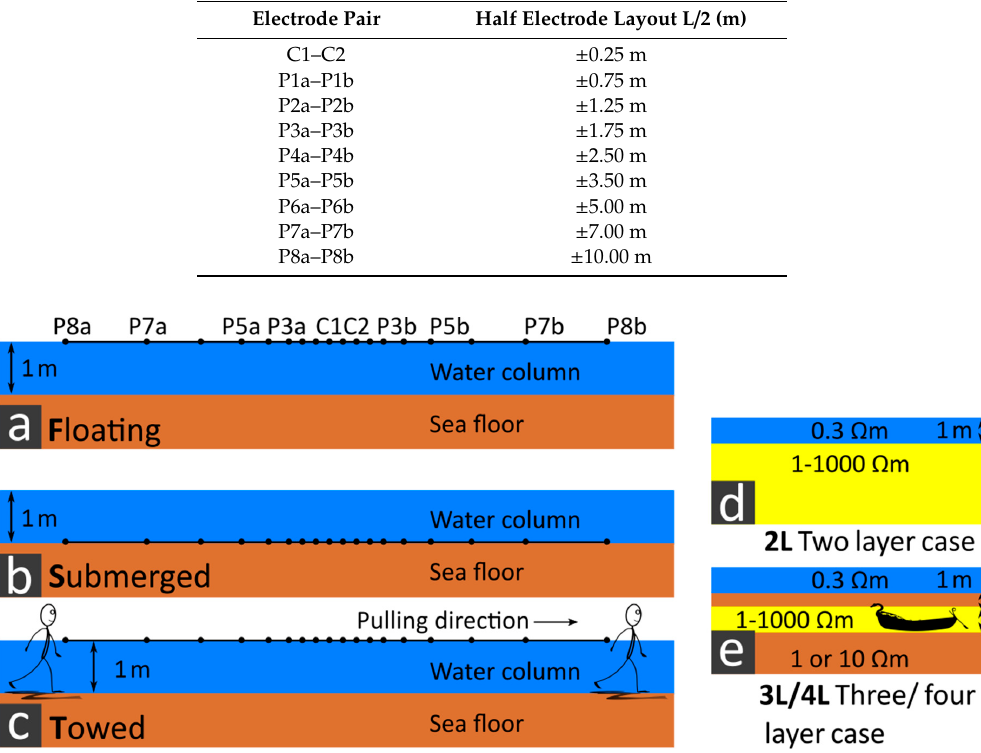
Table 1. Inverse Schlumberger configuration used for Eckernförde repetition measurements.